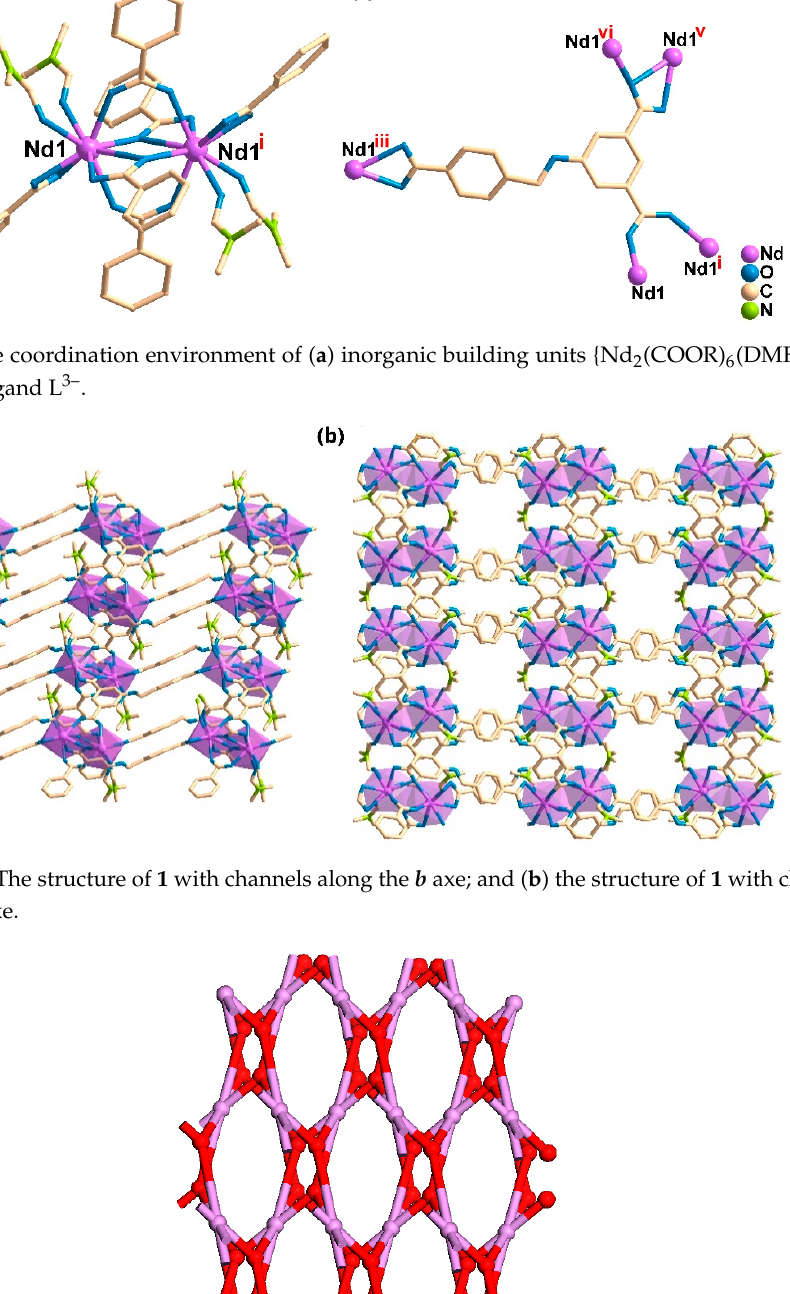
Figure 3. Schematic representation of the (3,6)-connected net of compound 1 . 3.3. Thermal Stability Analysis Thermogravimetric analyses (TGA) were performed to investigate the thermal stabilities of compounds 1 and 2 using single crystal samples under N 2 atmosphere. As shown in Figure S1,